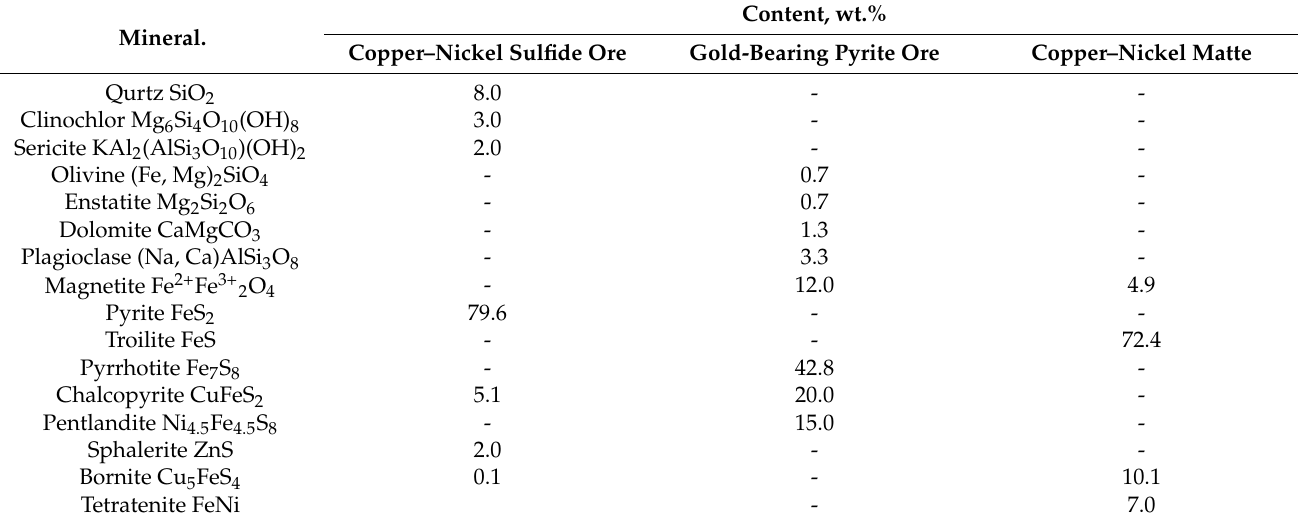
Table 2. Mineral composition of the investigated